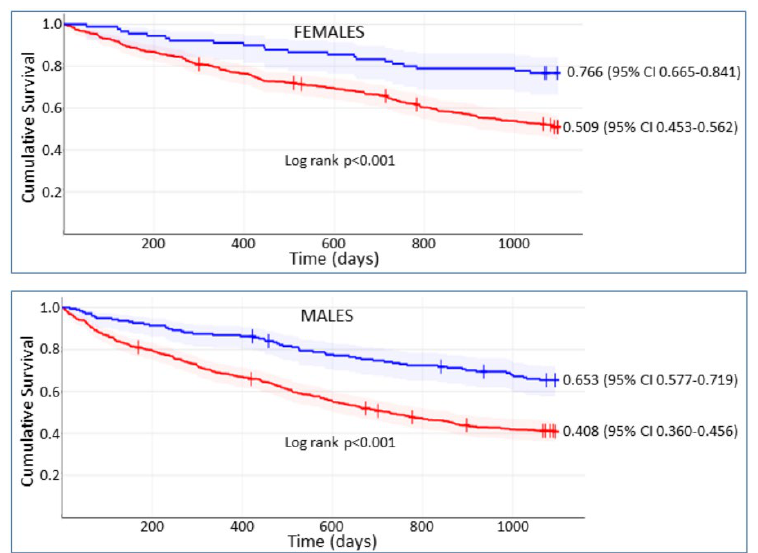
Figure 2. Survival curves for females and males who did (blue lines) or did not achieve (red lines) an increase in 6-min walk distance at discharge to values higher than the optimal threshold for predicting mortality.